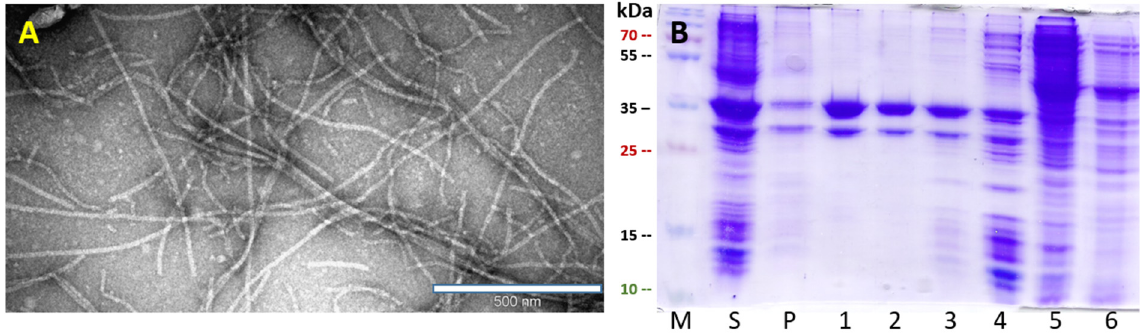
Figure 3. PVY-NG4S-SpyT analysis. ( A ) Electron micrographs of negatively stained VLPs; ( B ) Coomassie-stained SDS–PAGE. M—PageRulerTM Plus Prestained Protein Ladder (Thermo Fisher Scientific). S—soluble proteins in cell lysate; P—insoluble proteins in cell lysate; 1–6—sucrose gradient fractions (60–0% sucrose).